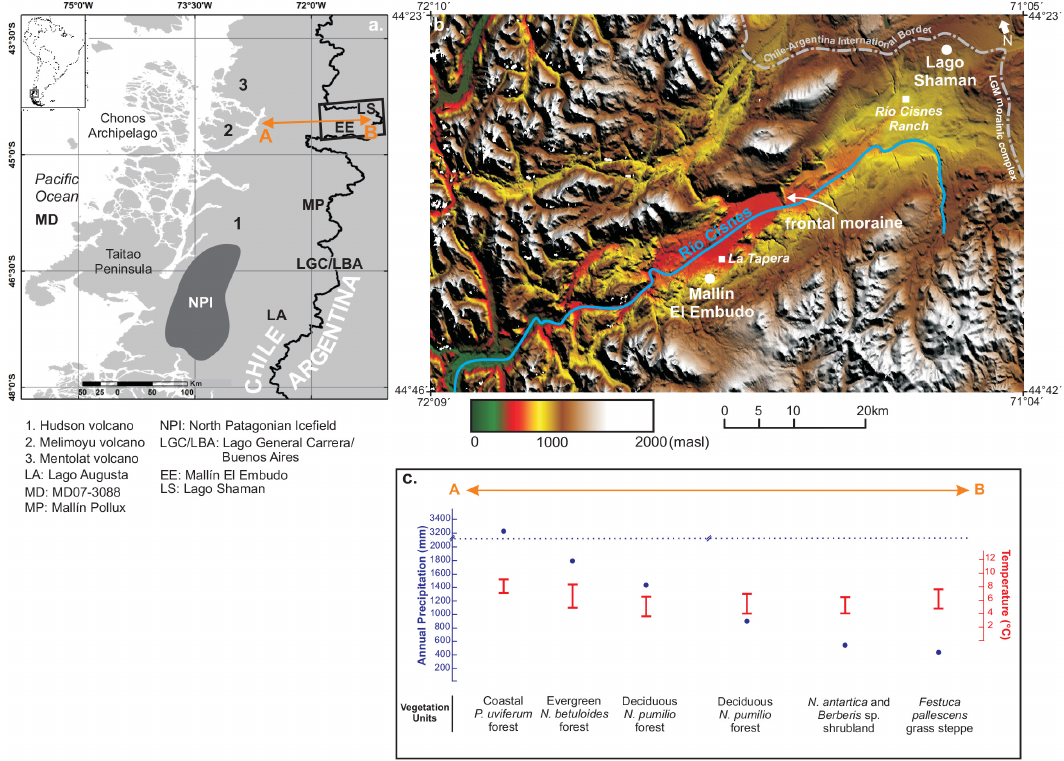
Figure 1. (a) Map showing location of Río Cisnes valley (black square) and sites mentioned in the text; (b) upper and middle Río Cisnes valley digital elevation model (DEM) showing location of Mallín El Embudo and major geomorphological features; (c) annual precipitation, mean annual temperature and major vegetation units along a west–east transect within the Río Cisnes valley